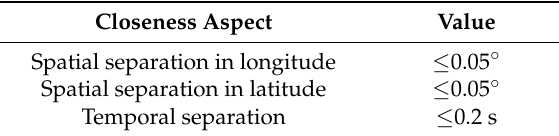
Table 1. Spatial and temporal threshold values to meet closeness requirement collecting groups into flashes.